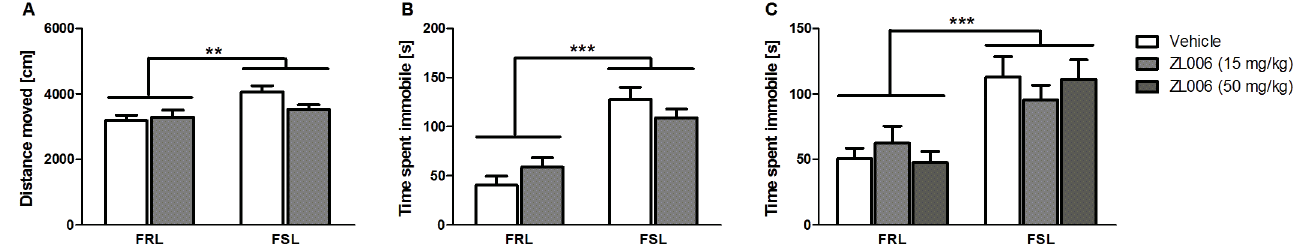
Fig 2. Acute systemiceffectsin Flinders Sensitive/Resistant Line rats 1 h after injection of vehicle or ZL006 (15 mg/kg (B); 15–50 mg/kg (C)). A : Locomotionduringa 5-min Open Field session. A significantstrain difference indicatedthat FSL rats moved a greater total distancethan FRL rats; ** : p (cid:20) .005; n = 7/group. B : Immobility duringa 5-min Forced Swim Test session. A significantstrain difference indicatedthat FSL rats were more immobilethan FRL rats; *** : p (cid:20) .001; n = 7/group. C : Replicationof B with the inclusionof an additionaldose (50 mg/kg). A significantstrain difference indicatedthat FSL rats were more immobilethan FRL rats; *** : p (cid:20) .001; n = 6–8. Values represent means ± SEM and were analyzed using two-way ANOVAs followedby pairwisecomparisons.